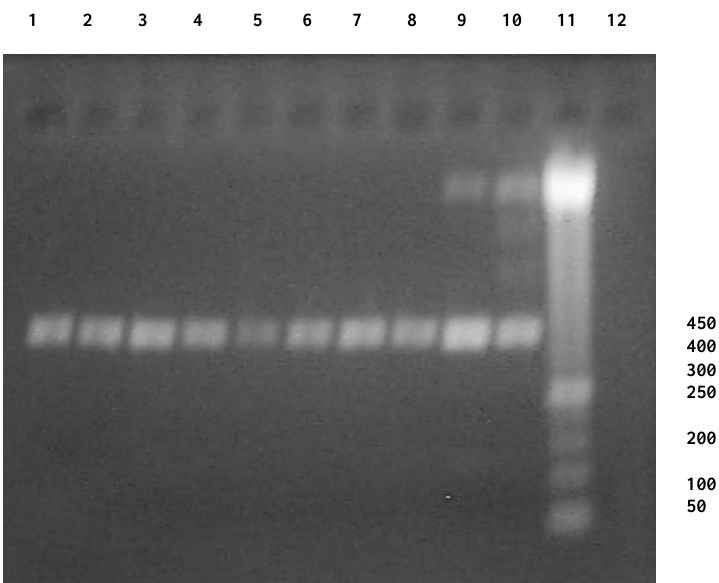
Figure 2. Agarose gel electrophoresis showing the PCR amplified products of the delta toxin gene ( hld ) in S. epidermidis (444 bp). Lanes 1-9, S. epidermidis strains isolated from neonates and positive for the hld gene; lane 10, S. epidermidis ATCC 12228; lane 11, molecular weight marker (50 bp); lane 12, negative